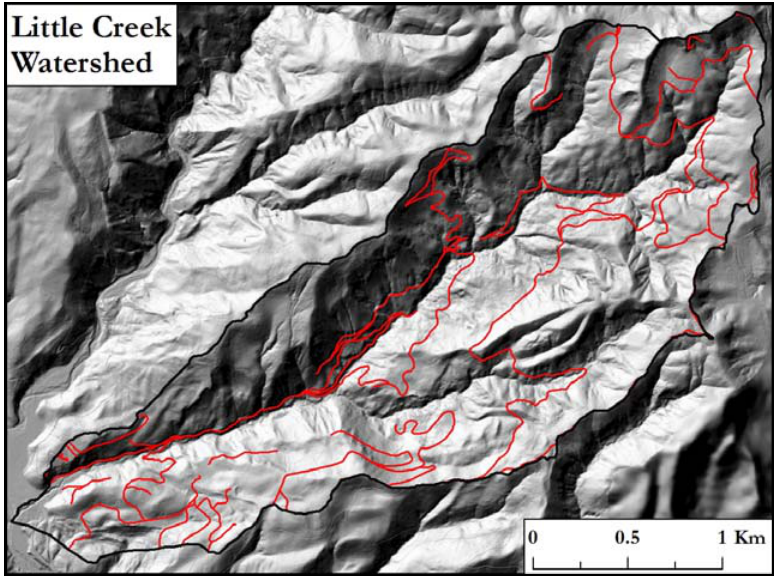
Figure 9. LiDAR-derived roads in the Little Creek watershed.